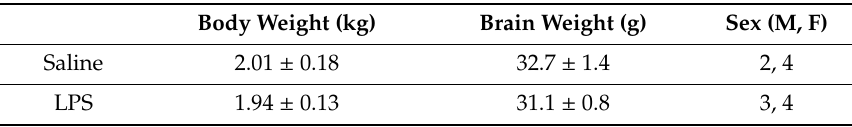
Table 1. Fetal body weight, brain weight, and sex.